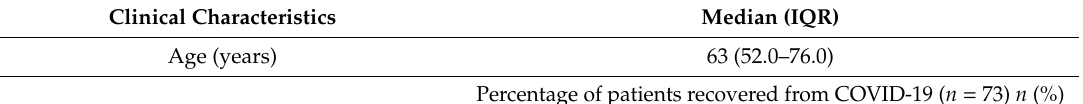
Table 1. Clinical characteristics and parameters of patients recovered from